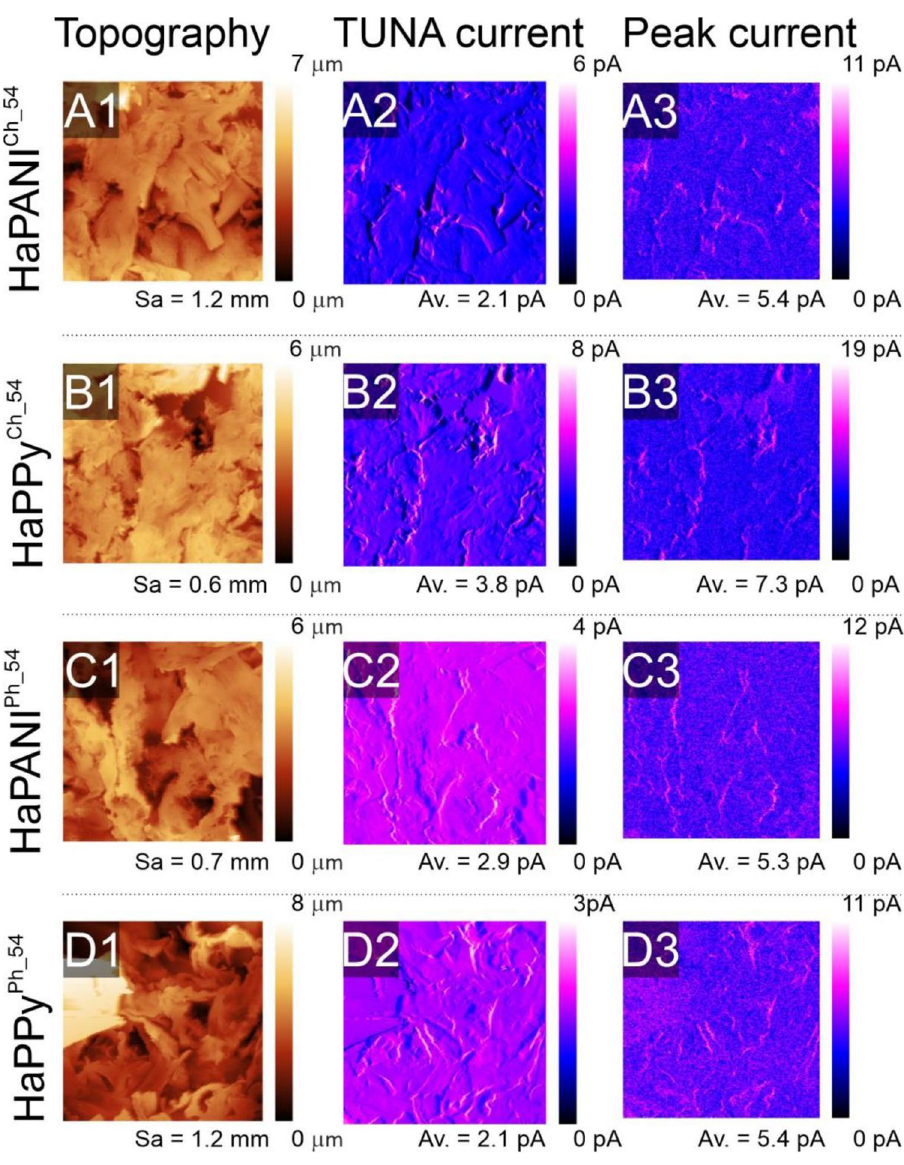
Figure 3. AFM images of HaPANI Ch ( A ), HaPPy Ch ( B ), HaPANI Ph ( C ), HaPPy Ph ( D ). The topography (1), TUNA current (2), and peak current (3) are presented for every